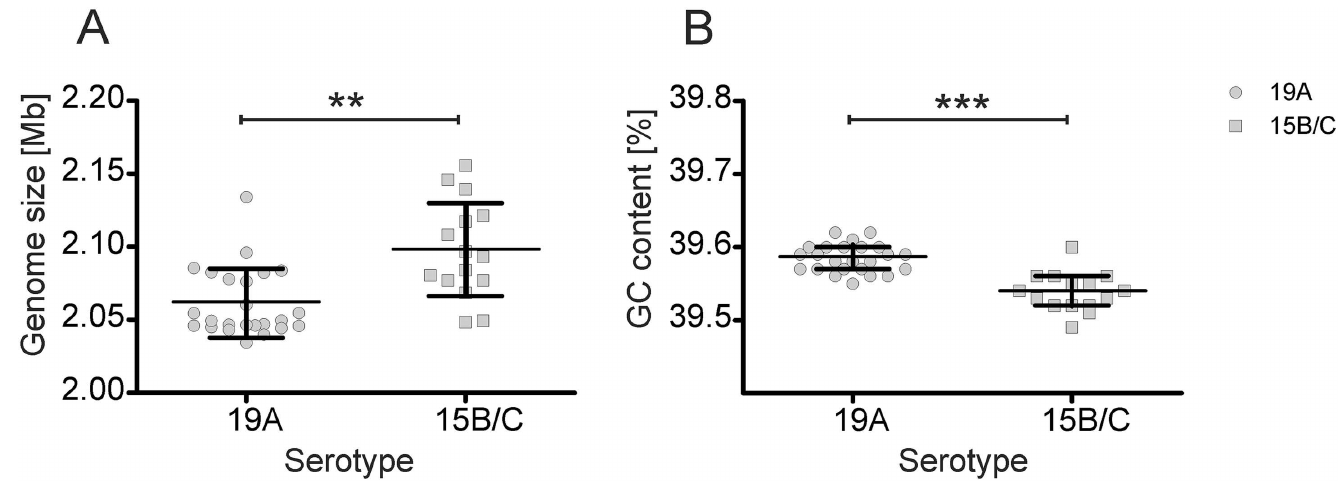
Fig 1. Distribution of the genome sizes (A) and the GC contents (B) of the analysed ST199 isolates with serotype 19A or serogroup 15B/C. Significance is indicatedby asterisks ( ** P < 0.0013, *** P < 0.0001).